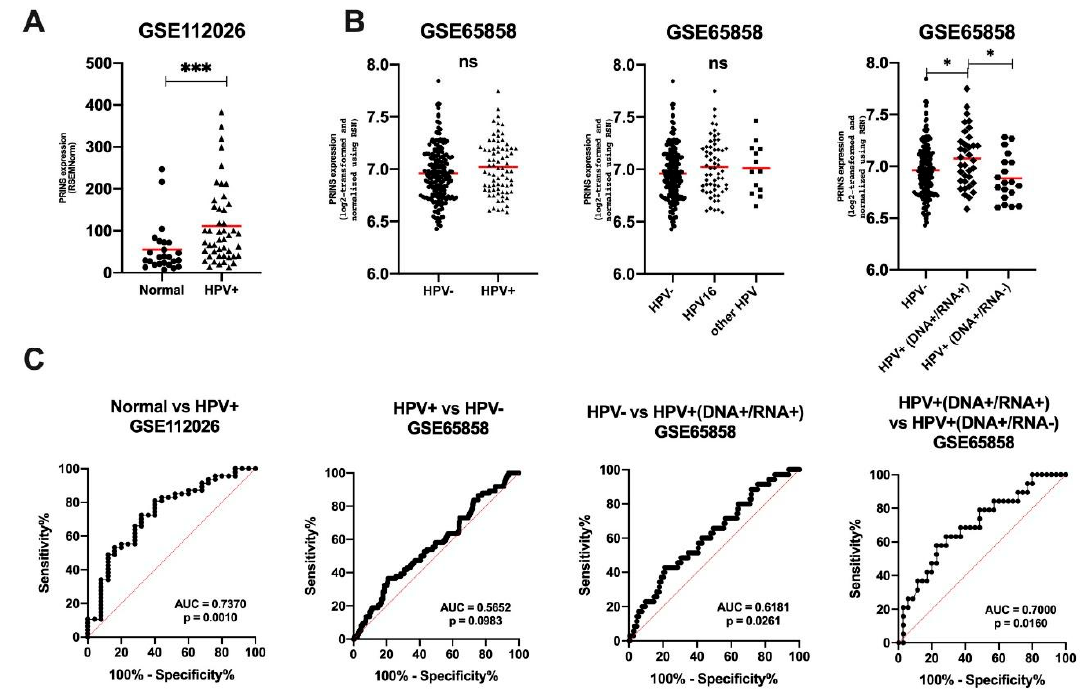
Figure 6. Expression of PRINS in HNSCC patients using GSE112026 and GSE65858 data sets: ( A ) in normal and HPV + samples; ( B ) depending on HPV status and ( C ) ROC analyses of PRINS’ ability to distinguish groups: normal vs. HPV + , HPV + vs. HPV − , HPV − vs. HPV + (DNA +/ RNA + ) and HPV + (DNA +/ RNA + ) vs. HPV + (DNA +/ RNA-); un-paired T-test or one-way ANOVA test with post-test. The graphs show median values; ns: not significant, * p < 0.05, *** p < 0.001.